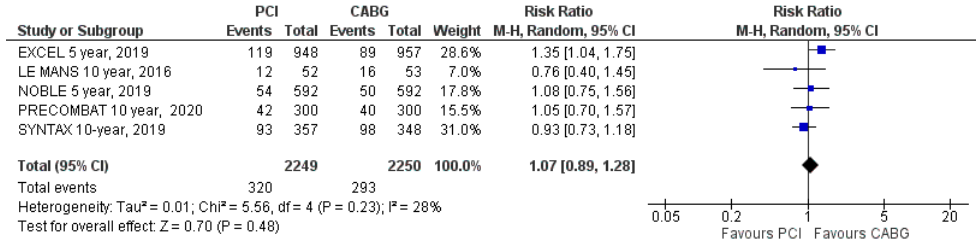
Figure 3. Risk of all-cause mortality at the latest follow-up: PCI vs. CABG.